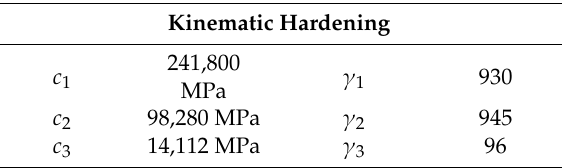
Table 2. Parameters of the kinematic hardening rule for the as-built EOS MS300, used in both the isotropic and the anisotropic plasticity